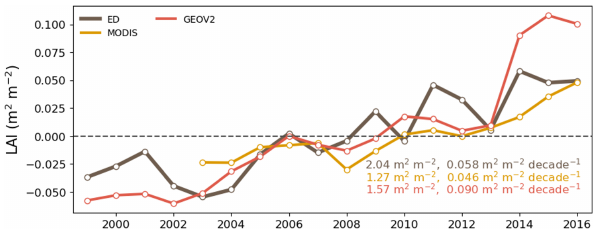
Figure 13. Interannual global average growing season LAI from ED, MODIS and GEOV2. The anomaly is calculated by subtracting the multi-year average from the annual